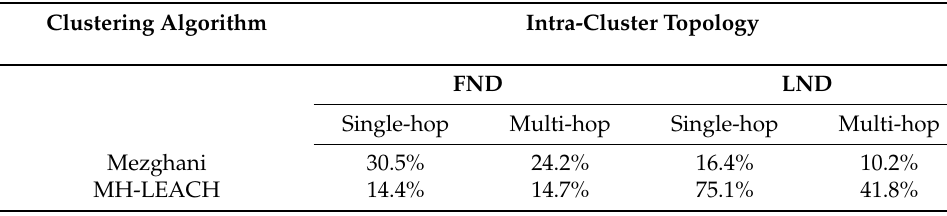
Table 7. Network lifetime gains compared with Mezghani and